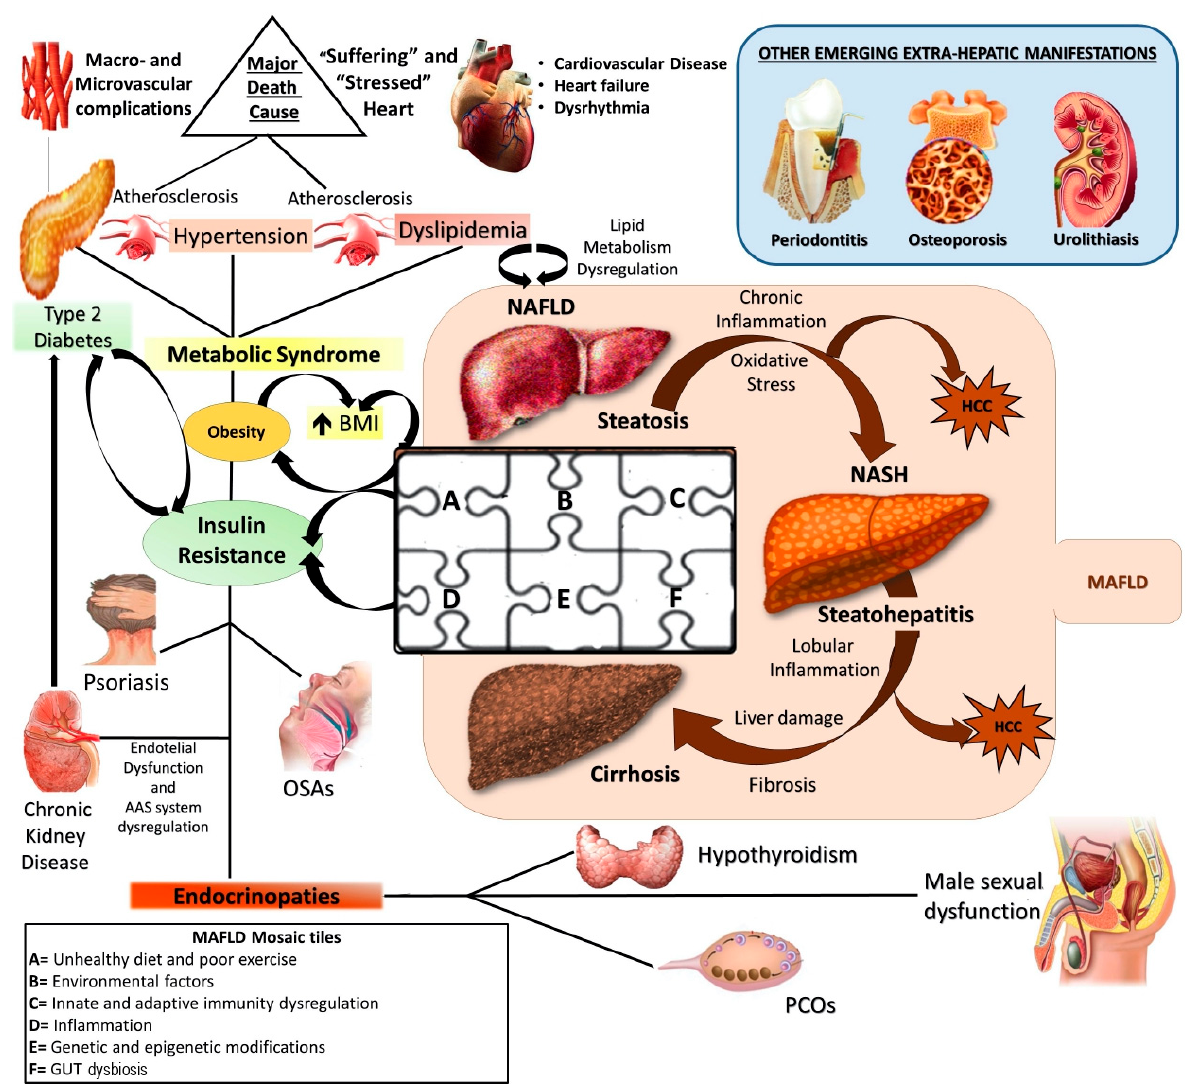
Figure 1. NAFLD: a metabolic systemic disease. The modern approach considers NAFLD as a metabolic, systemic disease characterized by several extra-hepatic manifestations mostly linked by a status of insulin resistance (IR). EDCs: Endocrine disrupting compounds; IR: Insulin resistance; MAFLD: metabolic (dysfunction) associated fatty liver disease; NAFLD: Non-alcoholic fatty liver disease; NASH: Non-alcoholic steatohepatitis; HCC: Hepatocellular carcinoma; OSA: Obstructive sleep apnea; PCOS: Polycystic ovarian syndrome; T2DM: Type 2 Diabetes Mellitus. Alarmingly, as the diffusion of MS-related conditions continues to increase and the obesity pandemic spreads irrepressibly, MAFLD prevalence, in turn, seems to rise exponentially [1]. The worldwide prevalence ranges from 6% to 35%, with higher levels in the industrialized countries (the Middle East 32%, South America 31%, United States 24%, and Europe 23%) and lower levels in the underdeveloped ones (14%) [5]. Moreover,